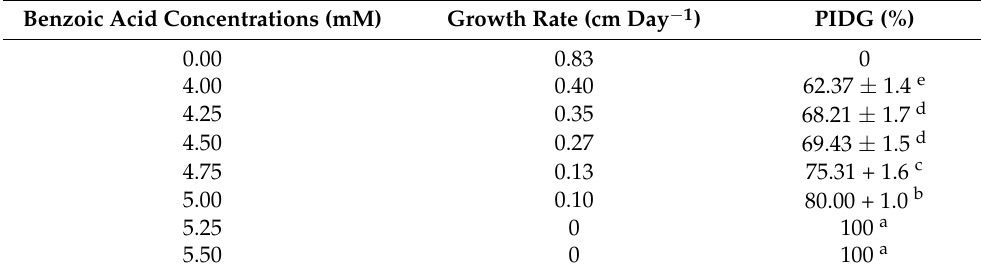
Table 1. Percentage Inhibition of Diameter Growth (PIDG) of G. boninense on the media incorporated with different concentrations of benzoic